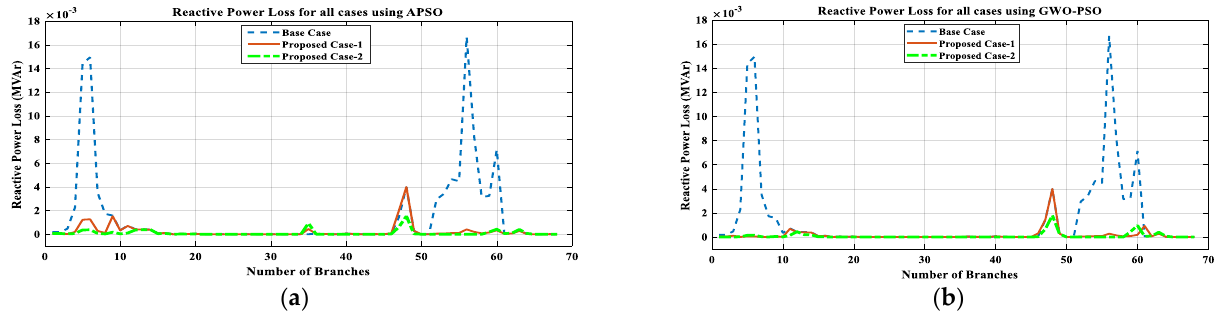
Figure 22. Reactive power loss for all cases of 69-bus RDN; ( a ) APSO, ( b ) GWO-PSO.